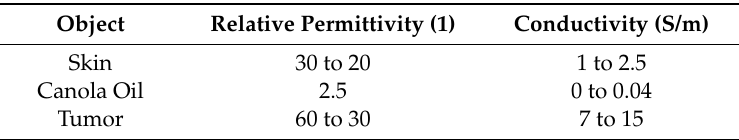
Table 2. Electrical properties of the simple breast model elements.